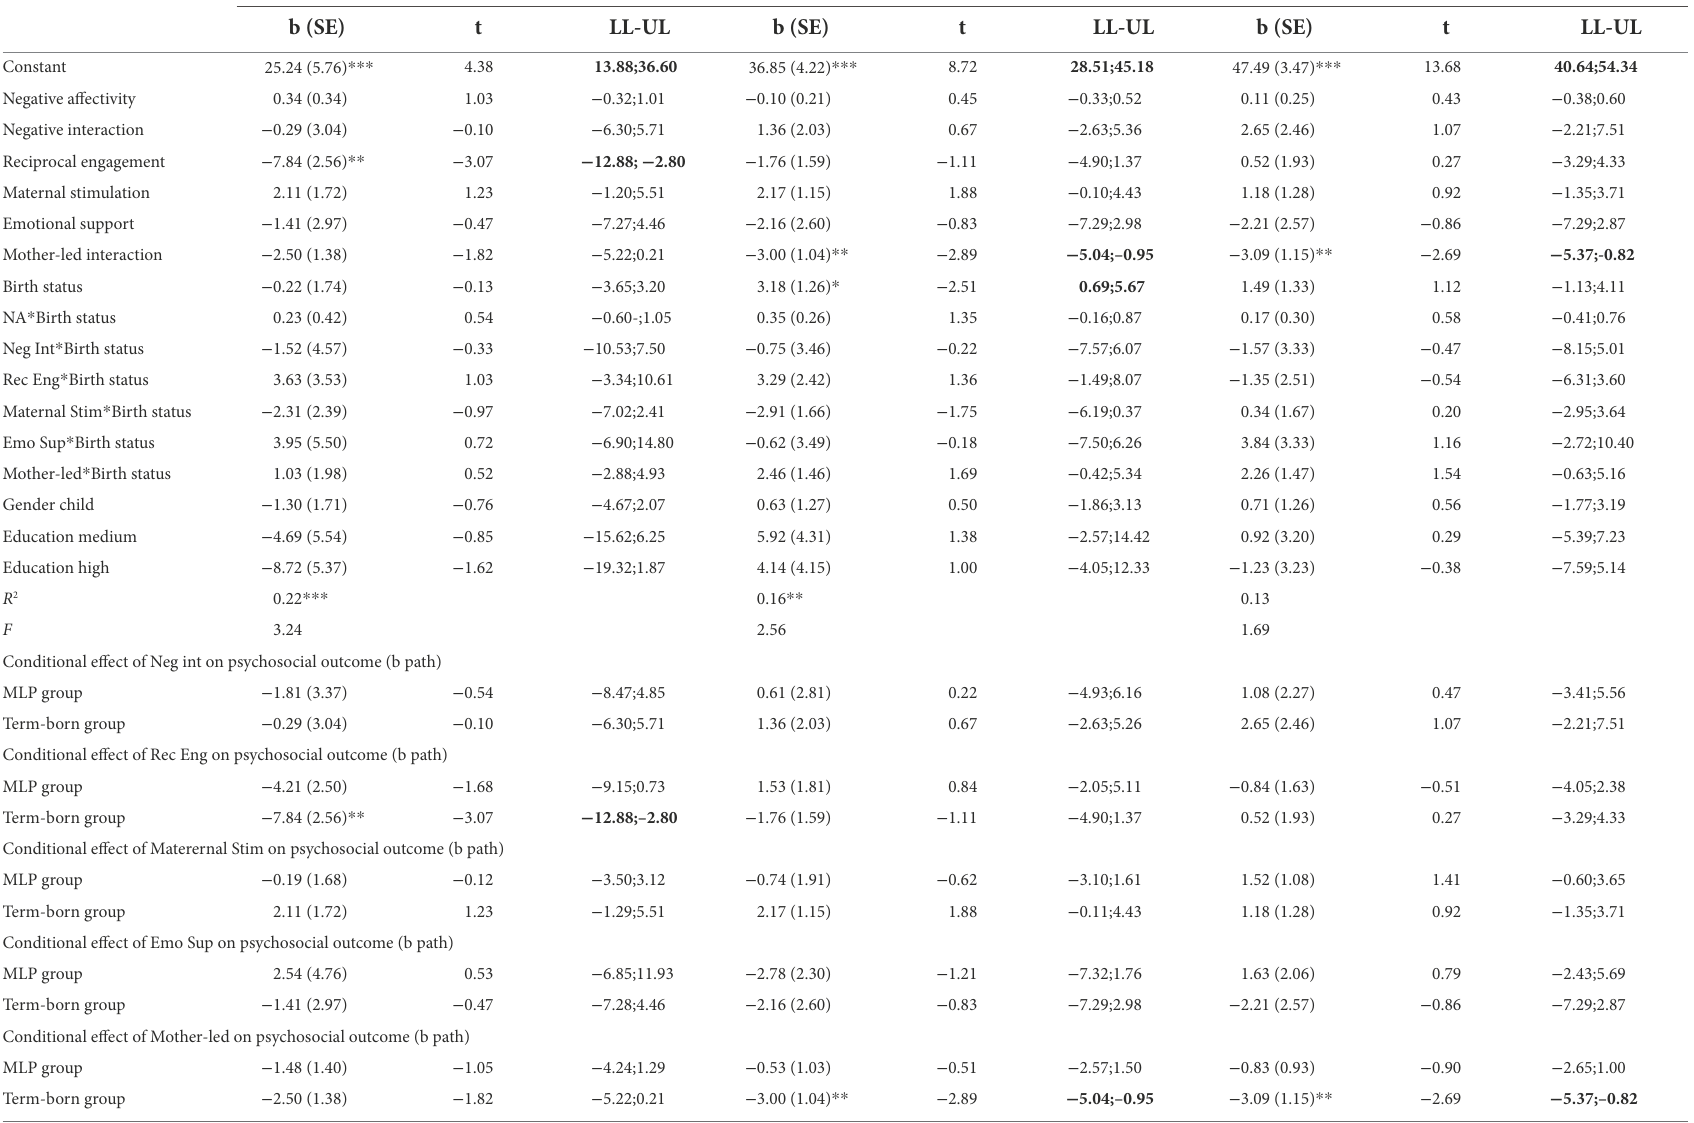
TABLE 5 Moderated-mediation model, representing the b, c’, and ab paths as well as the index of moderated